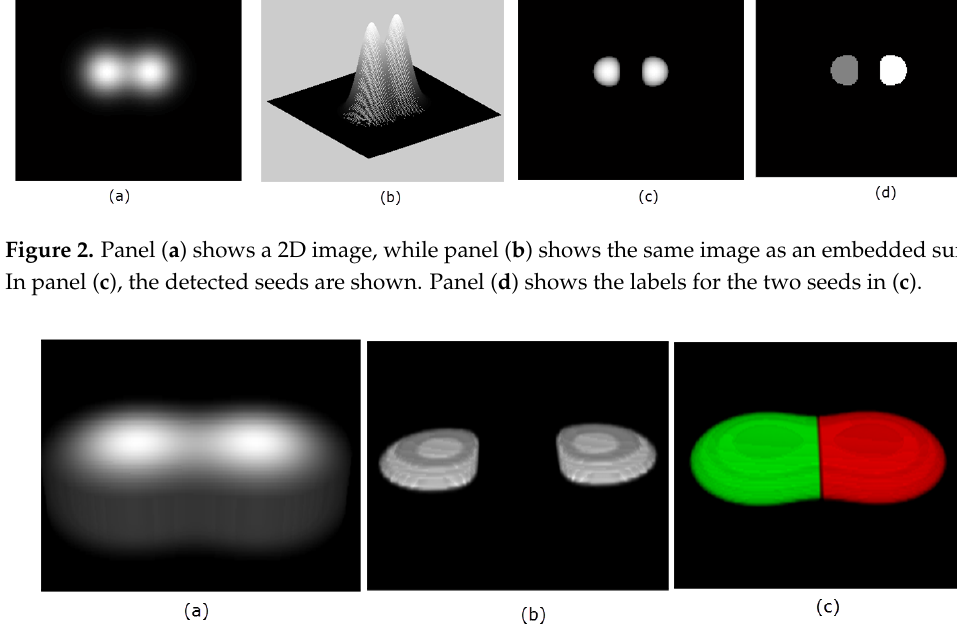
k + k + , are visualized in 3D in 2 3 1